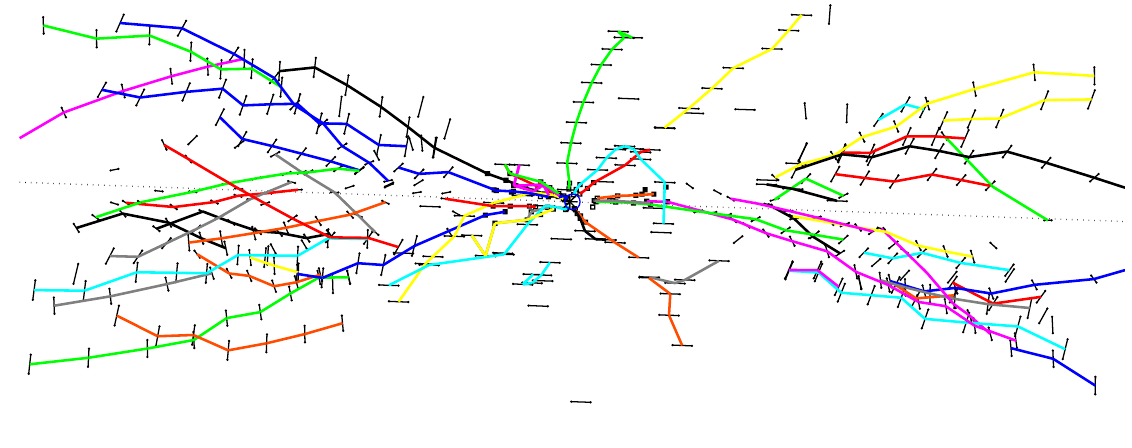
Figure 2. Chains of connected hits, taken as initial clusters in the k -medians clustering method.